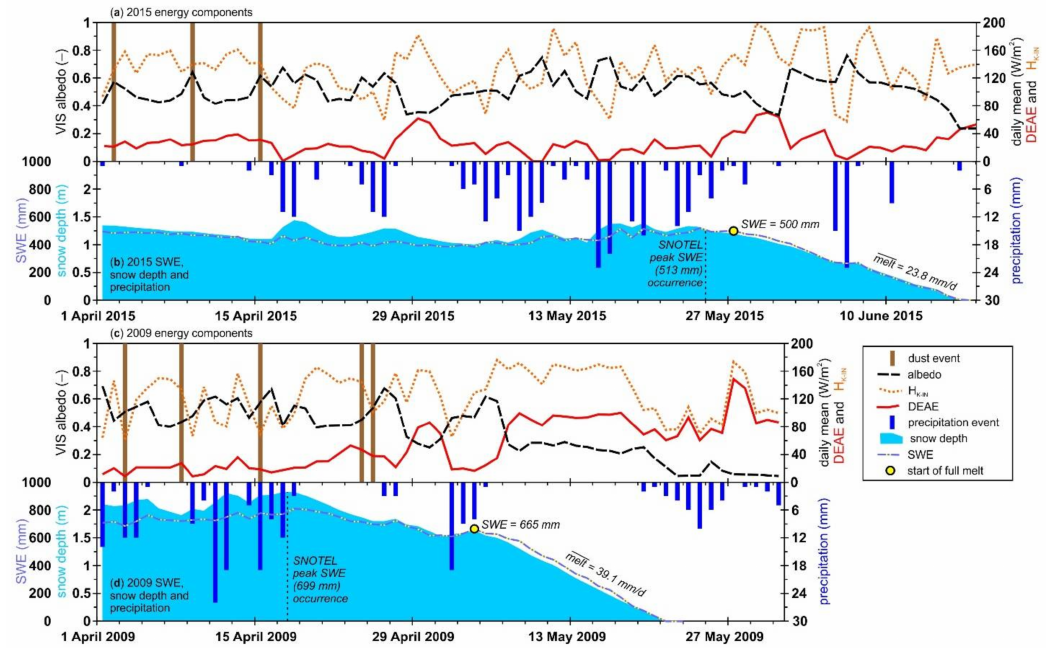
Figure 4. Summary of April through SAG illustrating ( a , c ) snow surface albedo (black dashed), daily mean DEAE (red), incoming shortwave radiation in the visible portion of the spectrum (orange dotted), and the occurrence of dust events (brown lines), and ( b , d ) snow depth (solid blue), daily precipitation inputs (blue vertical bars), and estimated SWE (dash-dot blue). The date and amount (in parentheses) of peak SWE at the nearby SNOTEL station is shown with a fine black dashed line. The date when the snowpack begins to melt consistently is denoted by a yellow circle and the estimated SWE at that time is stated. The average melt per day from that point to SAG is stated as melt . ( a , b ) represent WY2015 with the shortest ∆ SAG (11 days), the fewest dust events (3) and a low end-of-year dust concentration (0.79 mg/g); ( c , d ) represent WY2009 with the longest ∆ SAG (31 days), the most dust events (12), and a high end-of-year dust concentration (4.55